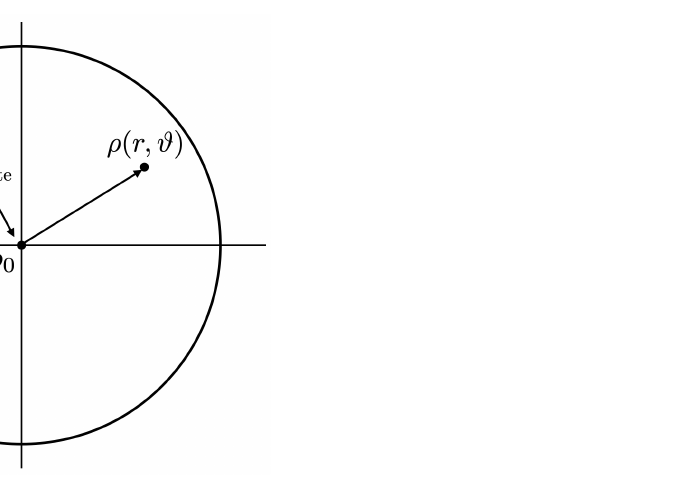
Figure 4. The unit (Bloch) disk D in R 2 , whose points represent quantum chromatic states. The points of its border S 1 represent pure quantum chromatic states and the center represents the achromatic